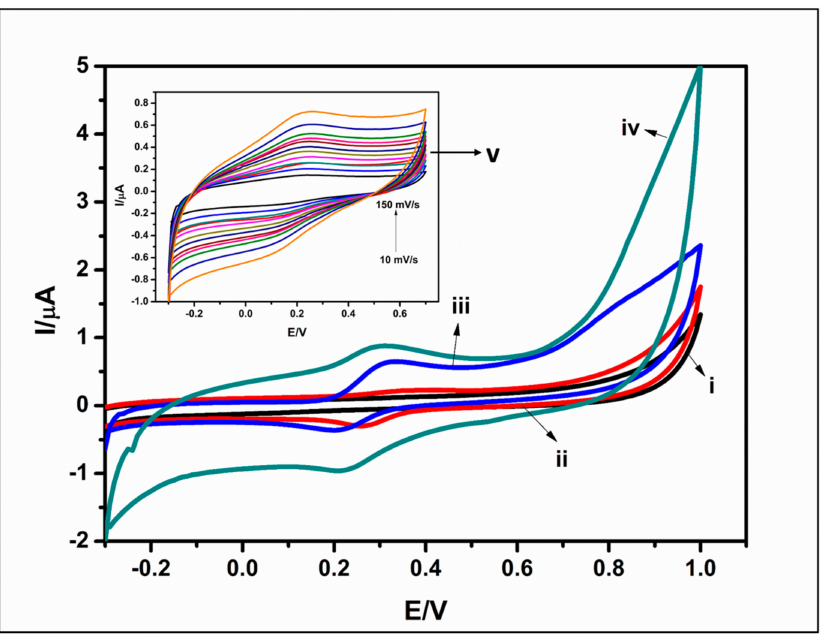
Figure 4. Cyclic voltammograms of GCE (i), GCE/QDs (ii), GCE/PPI (iii), GCE/PPI/QDs (iv), in 10 mM PBS (pH 7.2) at 50 mV.s − 1 . Insert: PPI/QDs/ChOx (v) in 10 mM PBS (pH 7.2) at different scan rates (10–150 mV.s − 1